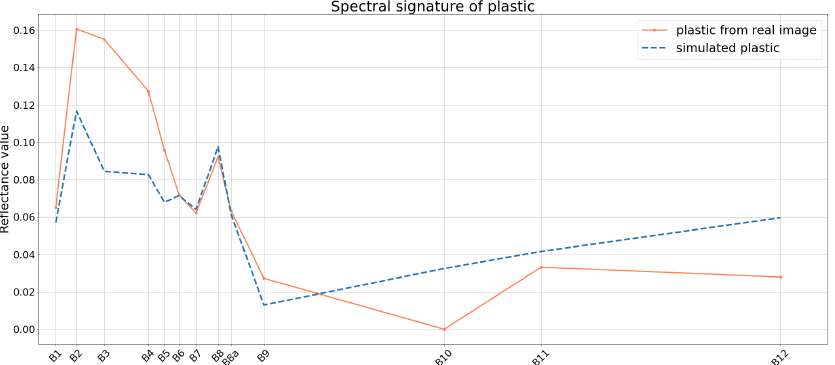
Figure 6. In orange, the spectral signature extracted from a 28 m diameter target deployed for the PLP21. Image filename: S2A_MSIL2A_20210611T085601_N0300_R007_T35SMD_20210611T121904. In